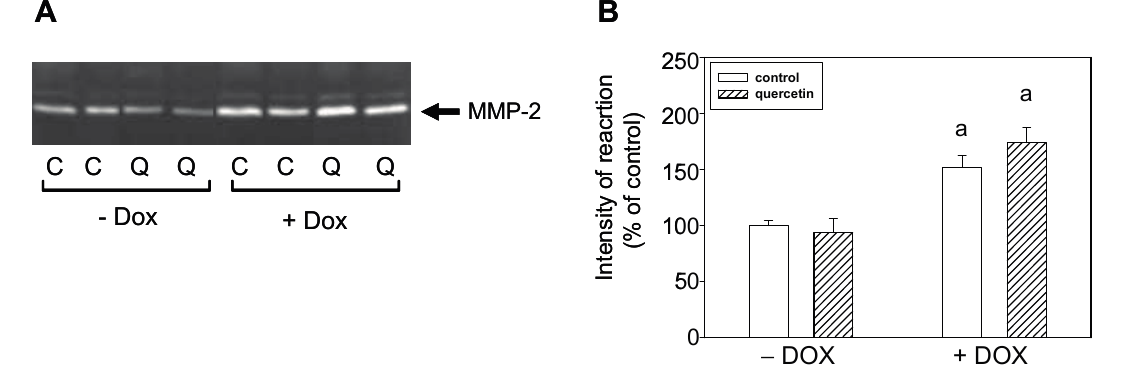
Figure 2. Effect of QCT and DOX treatment on tissue matrix metalloproteinase-2. ( A ) At the top is a record showing the activities of MMP-2 analyzed using gelatin zymography; in the middle, a western blot record showing MMP-2 protein levels analyzed using a specific antibody that reacts with both the 72 and 63 kDa forms of MMP-2, and at the bottom is documented the protein loading using GAPDH; ( B ) Quantitative analysis of the tissue 72-kDa MMP-2 activities. Data are expressed as a percentage of value for corresponding control. Each bar represents mean ± S.E.M. of seven independent tissue samples per group. Statistical significance is revealed by Student’s unpaired t -test, a p < 0.05 vs. control saline-treated ( − DOX) rats; b p < 0.05 vs. DOX-treated (+DOX) rats. By zymographic analysis of blood plasma samples we identified using positive controls the activities of 63- and 72-kDa MMP-2. We found significantly increased activities of 72-kDa MMP-2 in plasma of rats exposed to the prolonged effects of DOX (Figure 3). The observed increase in 72-kDa MMP-2 activities after DOX treatment in plasma correlated with increase of MMP-2 activities in the left ventricle. However, treatment with QCT failed to prevent the DOX-induced effects on activation of circulating plasma MMP-2 (Figure 3).